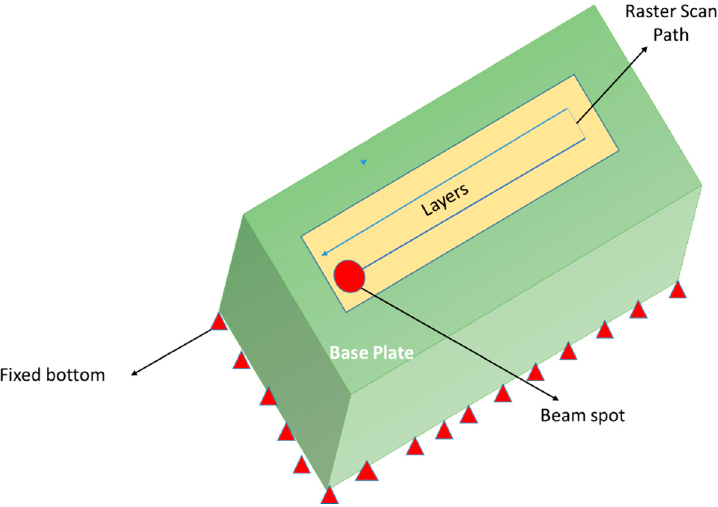
Figure 3. Electron beam movement.